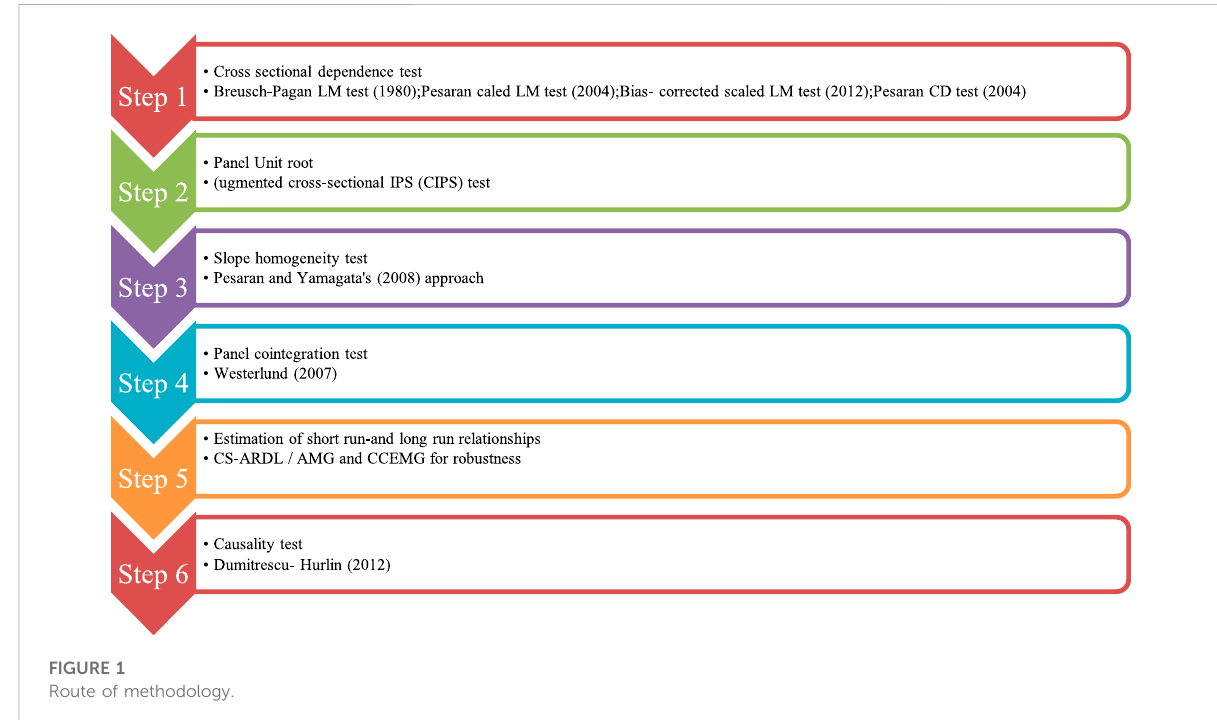
FIGURE 1 Route of